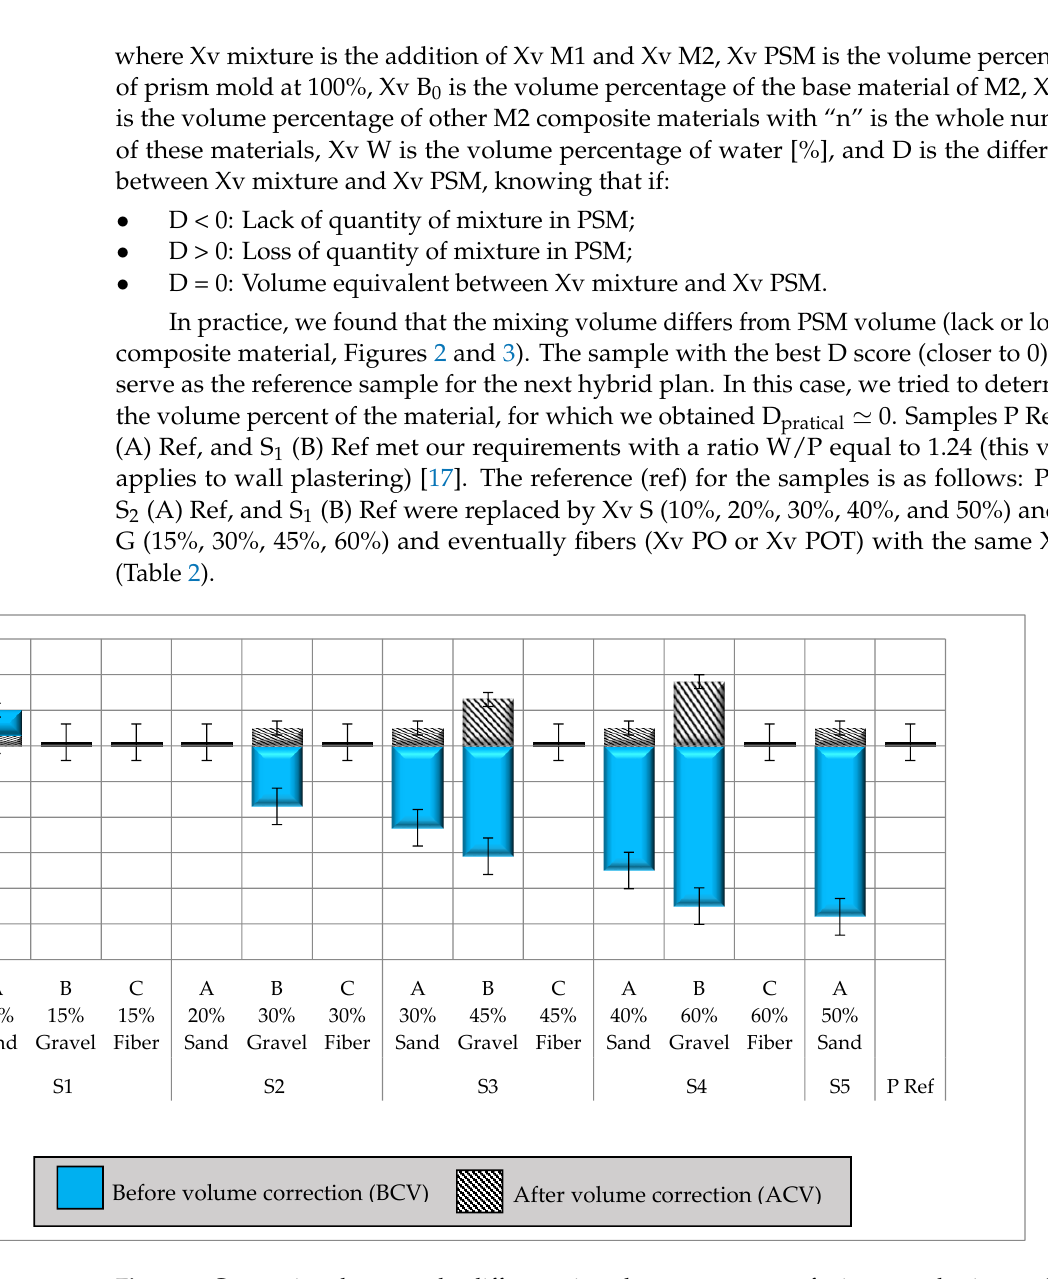
Figure 3. Comparison between the difference in volume percentage of mixture and prism mold ‘D’ before and after using the volume percentage correction factor. Table 2. Volume percentage of gypsum mortar [%].